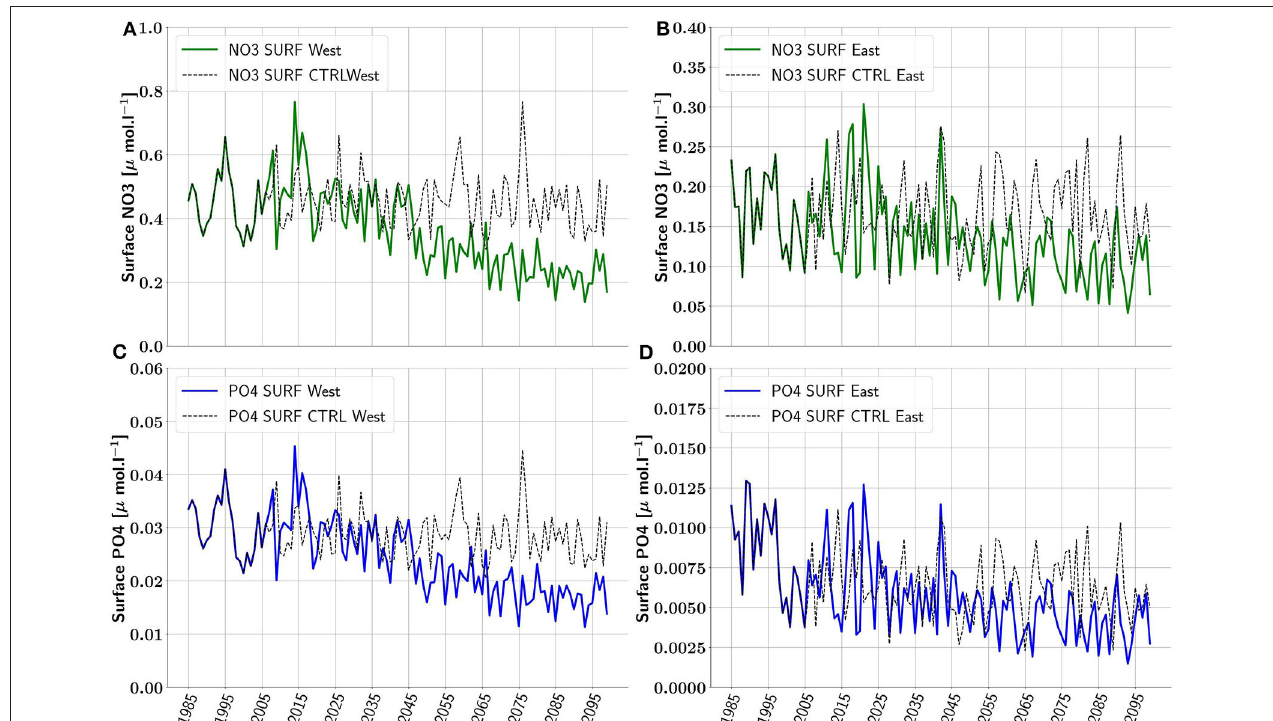
FIGURE 4 | Annual average of surface concentrations of NO 3 (green) and PO 4 (blue) in ( µ mol · l − 1 ) in the Western Basin (A,C) and the Eastern Basin (B,D) . Black dotted line shows the control simulation.